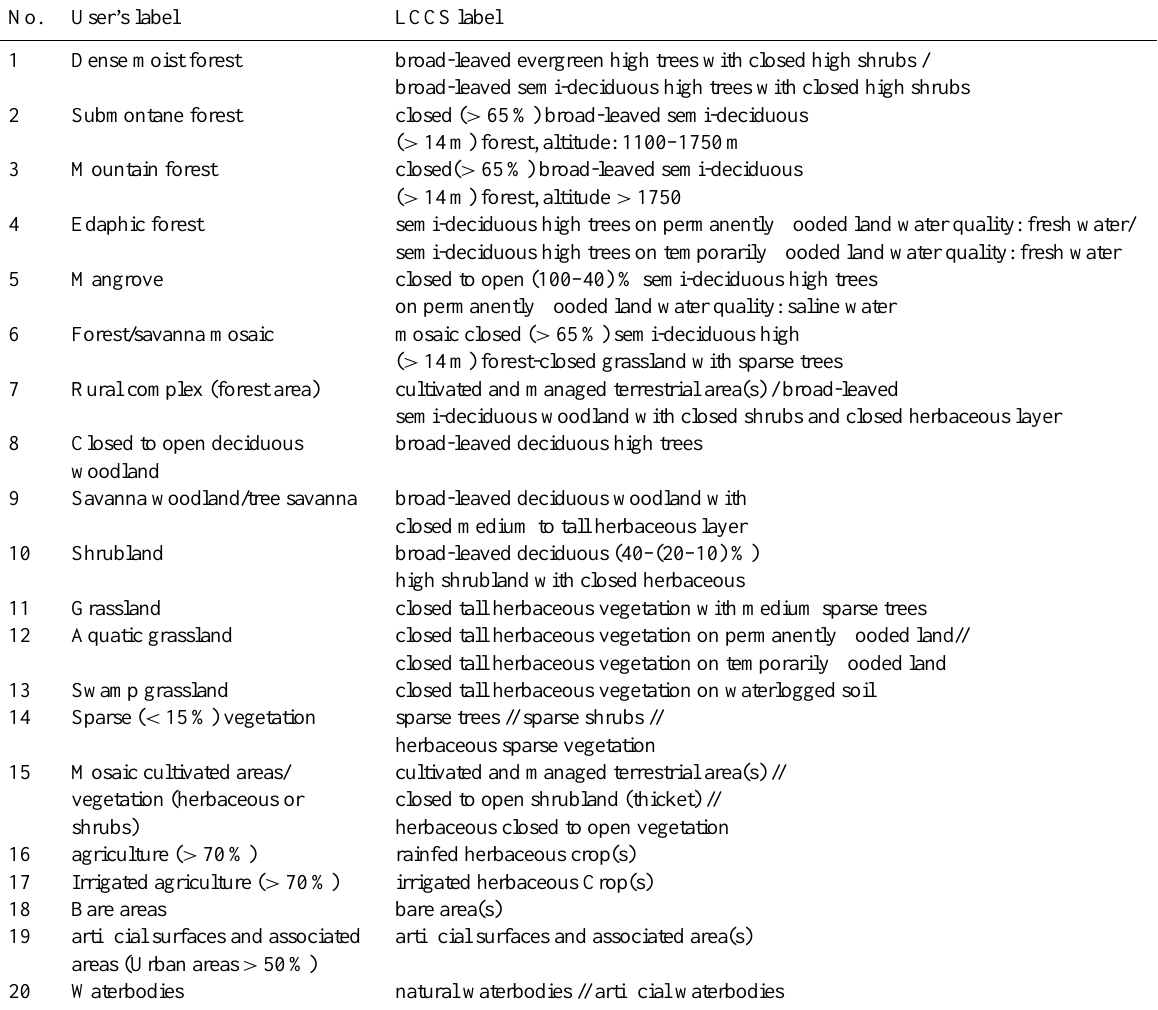
Table 2. User label and LCCS legends for the Congo Basin vegetation types map.